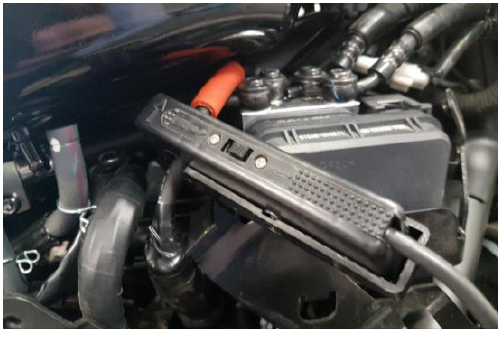
Fig. 5. Speed sensor mounted on the high voltage